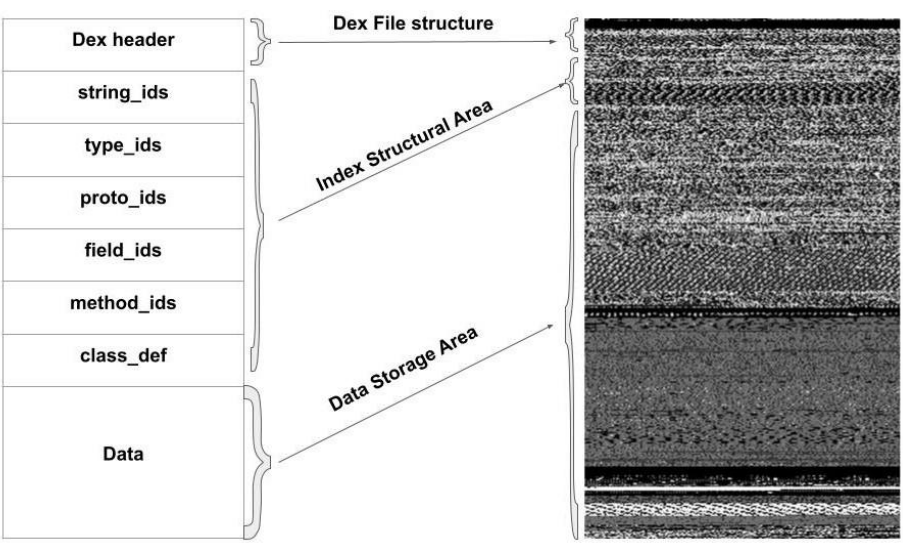
Figure 3. Sections of the image generated from binary that visually seem to have some correlation.